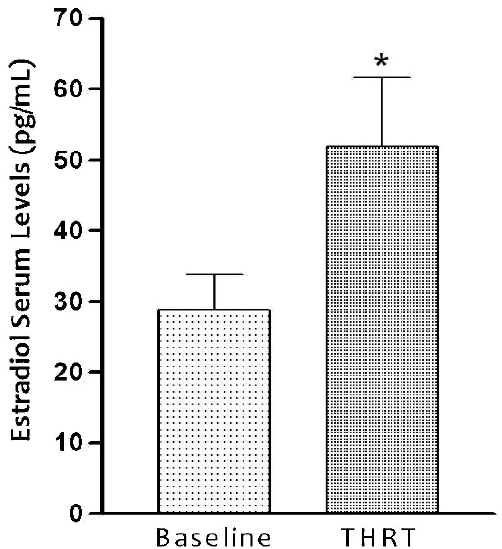
Figure 2 - Effect of the transdermal nanoemulsion on estradiol serum levels (ESLs) in 66 women receiving transdermal hormone replacement therapy (THRT) for 60 months. The nanoemulsion was administered topically in postmenopausal women. Mean values are shown, and the SEs are indicated by error bars. * p , 0.05 was considered significantly different from baseline values (Student’s t-test).